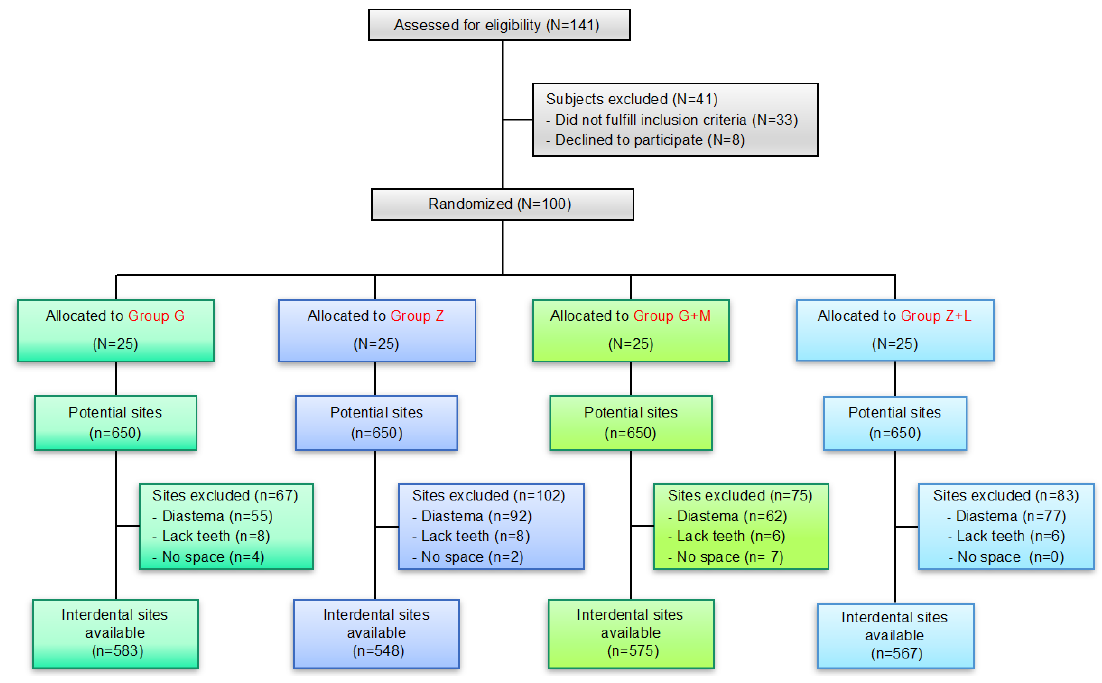
Figure 1. Flow chart of the study.